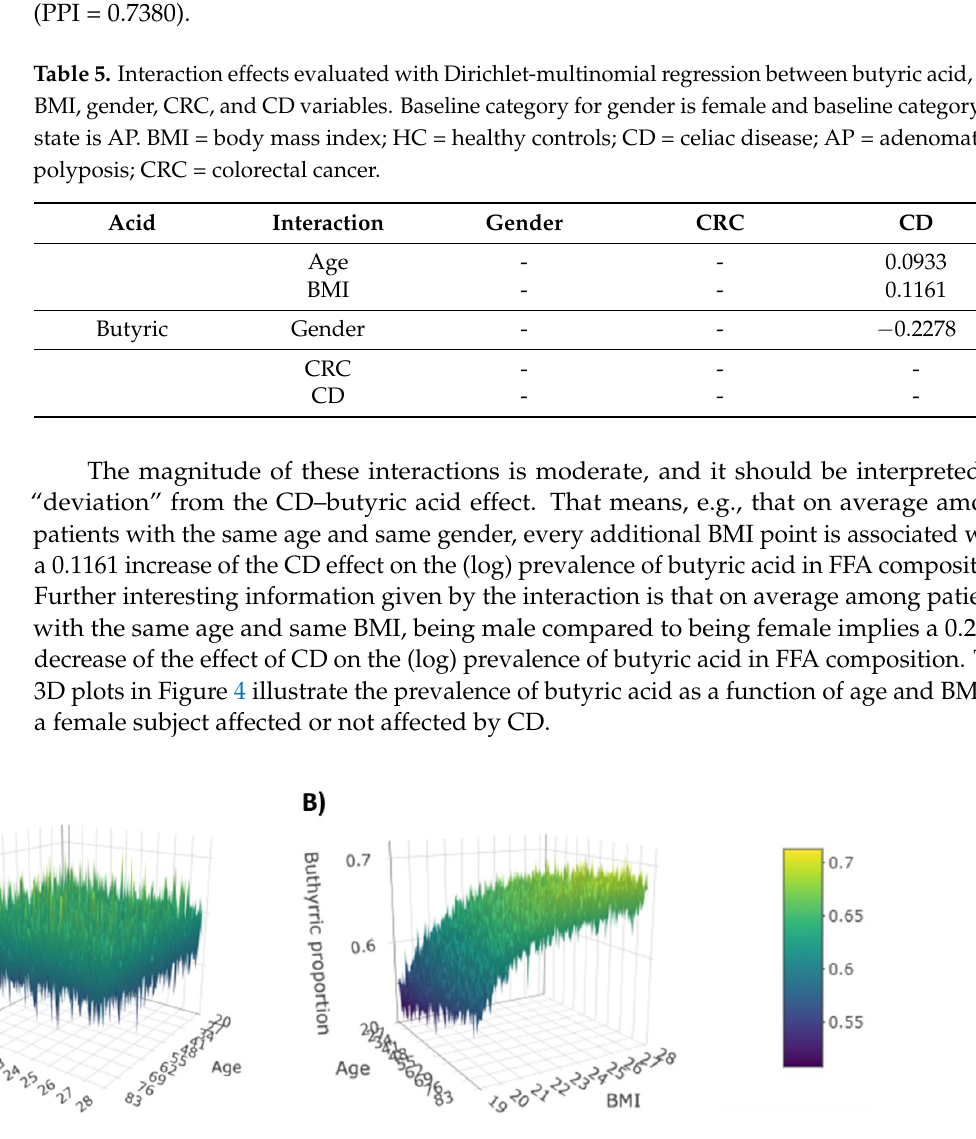
Figure 4. Prevalence of butyric acid for female without CD ( A ) and with CD ( B